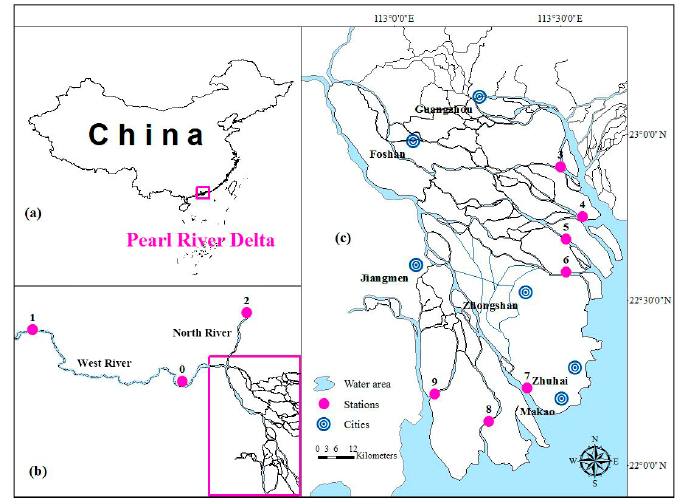
Figure 1. Map of Pearl River Delta and locations of gauge stations: ( a ) location of Pearl River Delta on the map of China; ( b ) gauge stations of upstream rivers; ( c ) a closer view of Pearl River Delta.